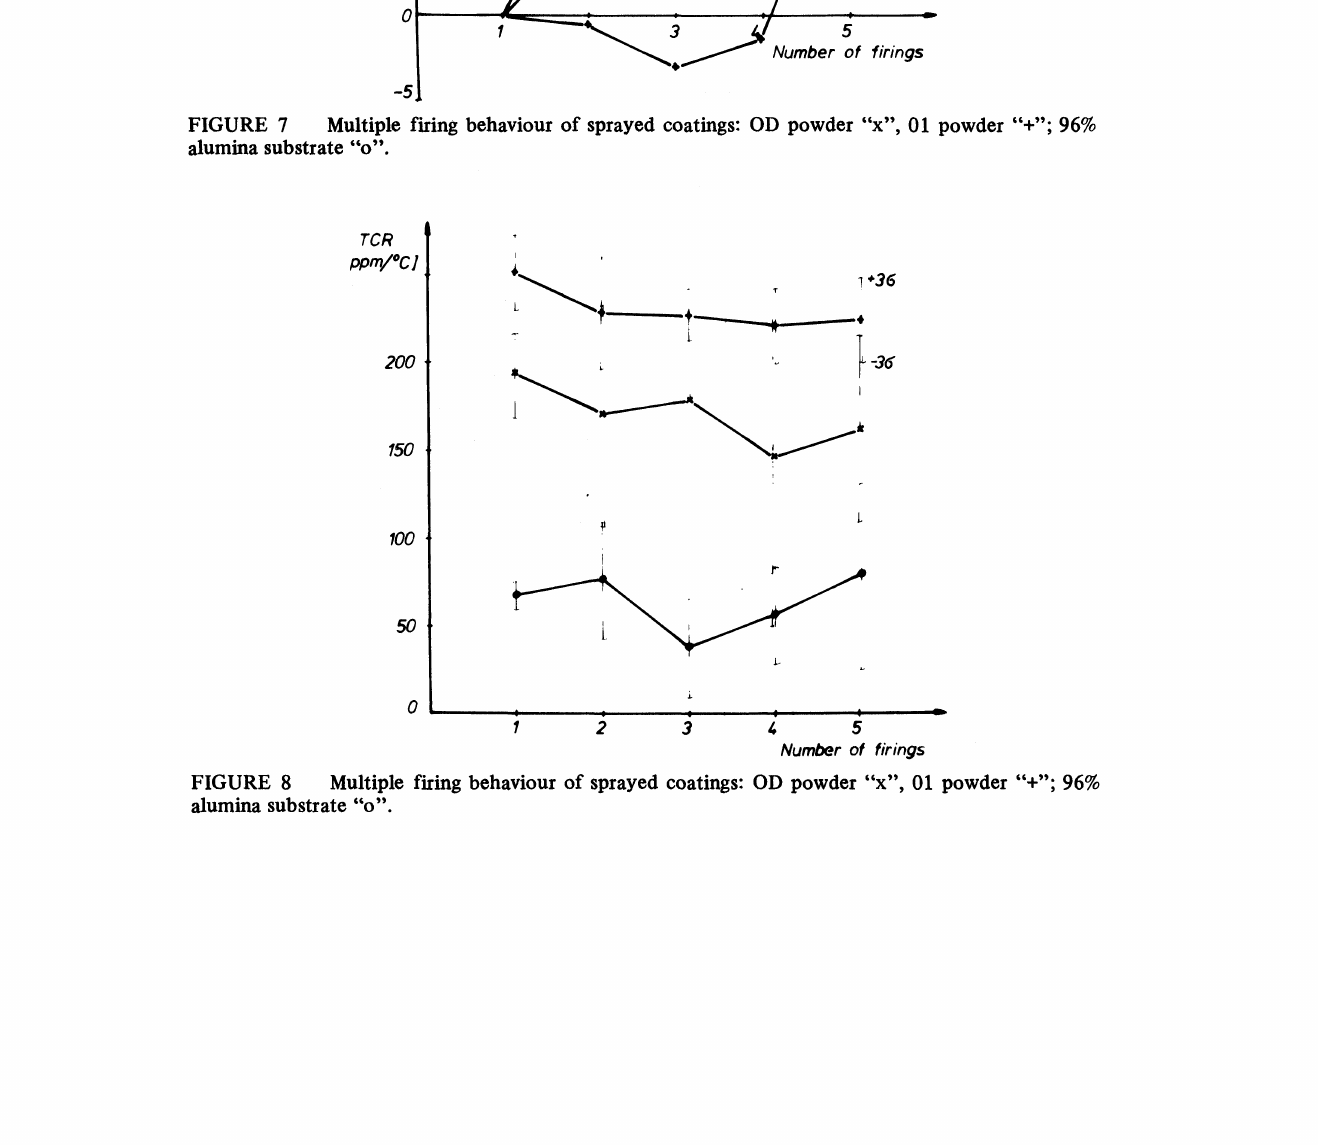
FIGURE 7 Multiple firing behaviour of sprayed coatings: OD powder "x", 01 powder "+"; 96% alumina substrate "o".